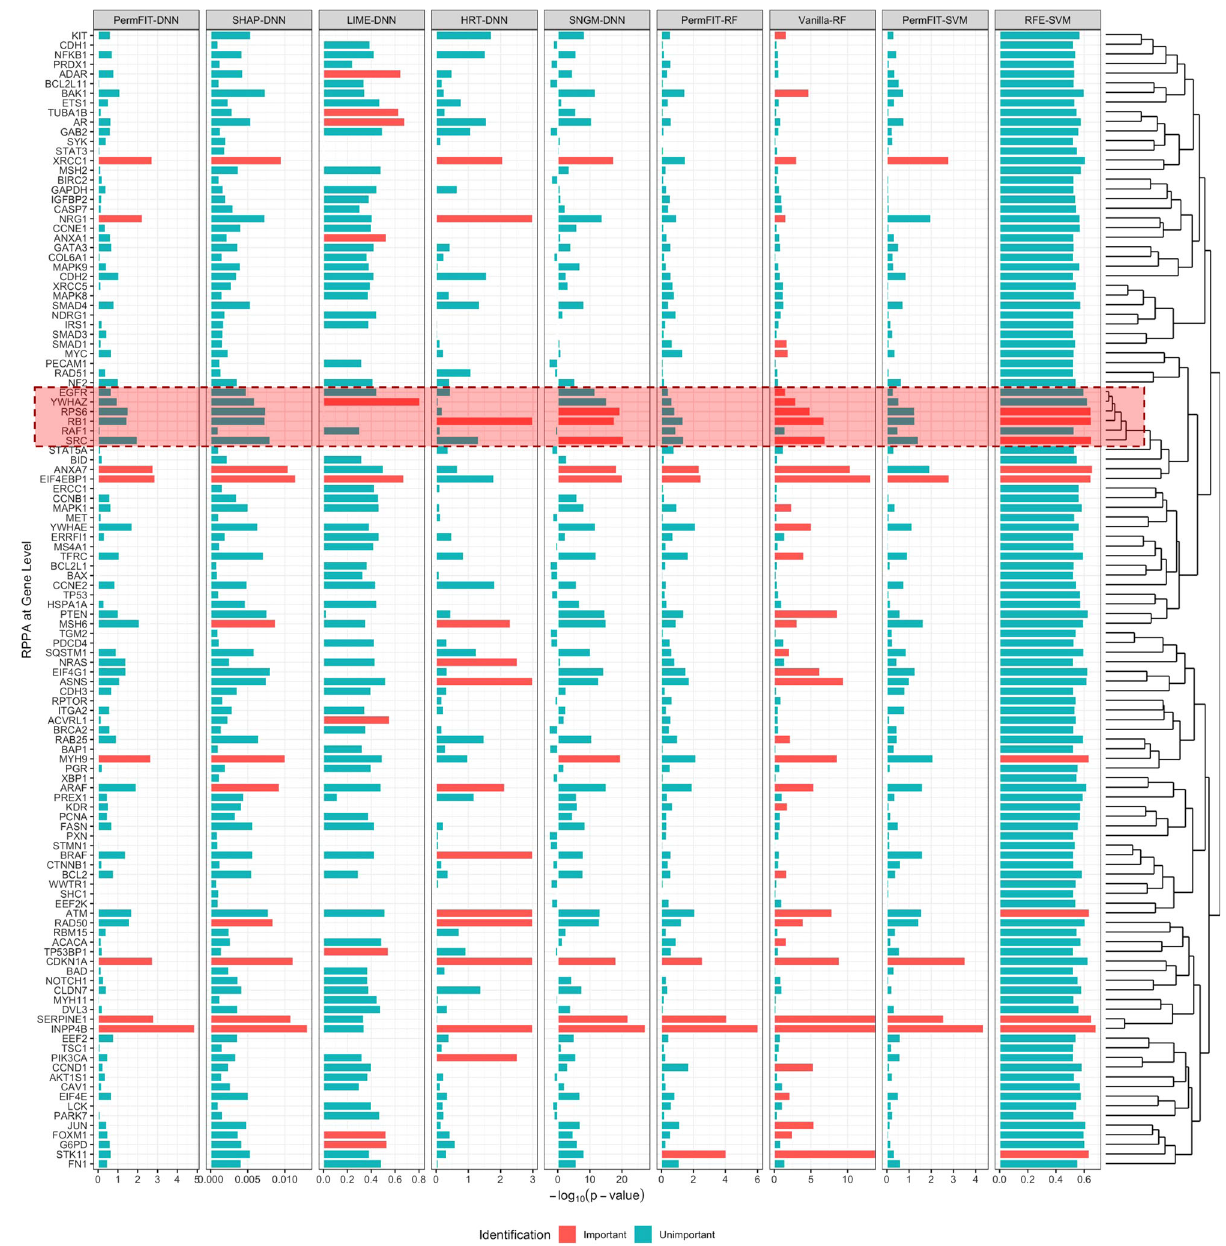
Fig. 2 Negative log 10 p values for TCGA kidney cancer data. Important features selected by each method is marked in red. Since SHAP-DNN, LIME-DNN, SNGM-DNN, and RFE-SVM do not produce a p value, its importance is presented instead, and 10 features with top importance scores are marked. The highly correlated features (see details from the dendrogram on the right) selected by RFE-SVM, Vanilla-RF, and SNGM-DNN, but not by PermFIT methods, are highlighted. Source data are provided as a Source Data fi